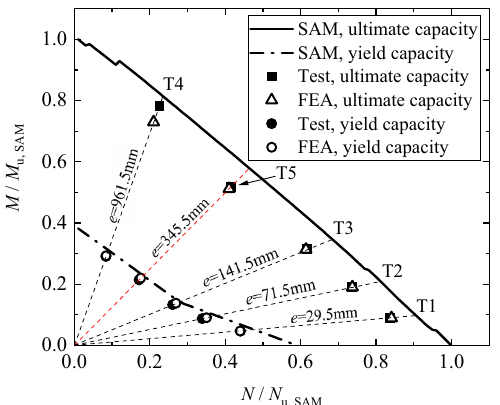
Figure 13. Interaction of tensile capacity with bending capacity.